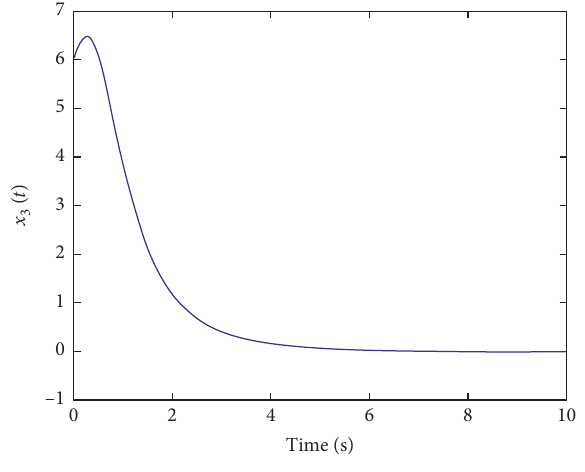
Figure 5: Responses of x